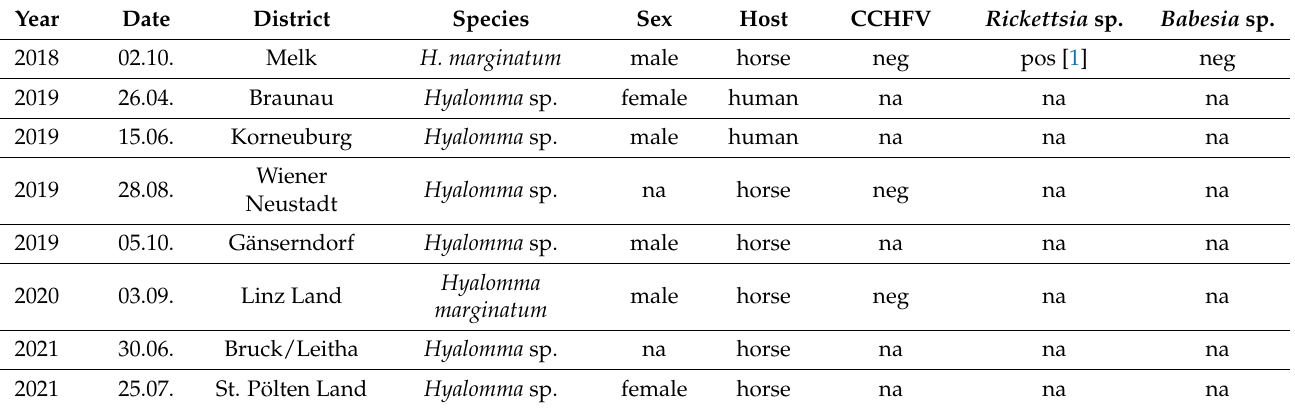
Figure 2. Hyalomma sp. findings in Austria in the years 2018–2021. Table 1. Species, sex and species of the host were identified in the case of ticks. Microorganisms were detected in the ticks. (CCHFV = Crimean-Congo-haemorrhagic fever virus, na = not available, neg = negative, pos =